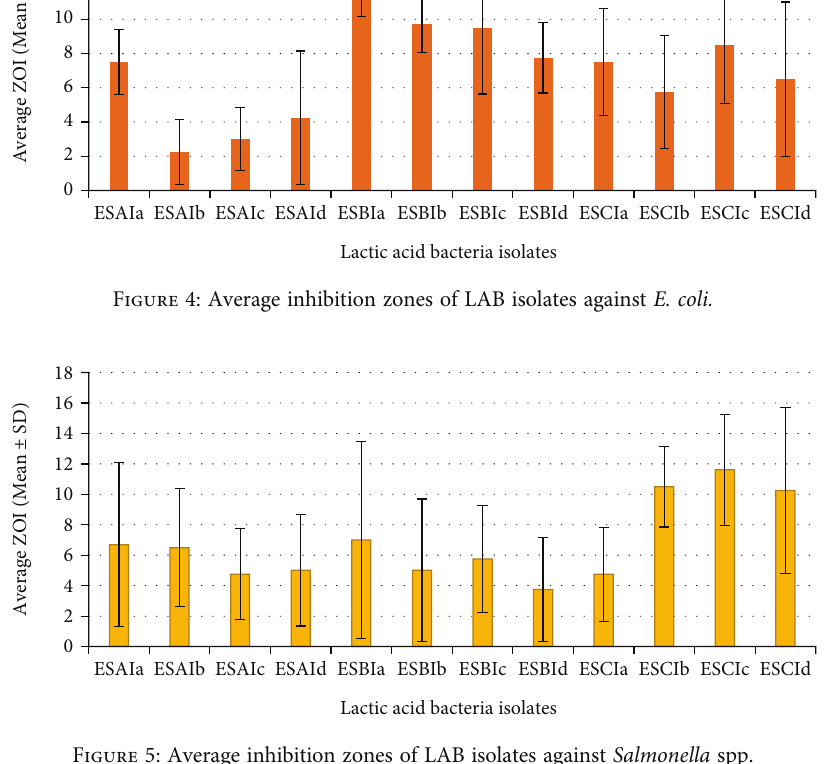
Figure 5: Average inhibition zones of LAB isolates against Salmonella spp.